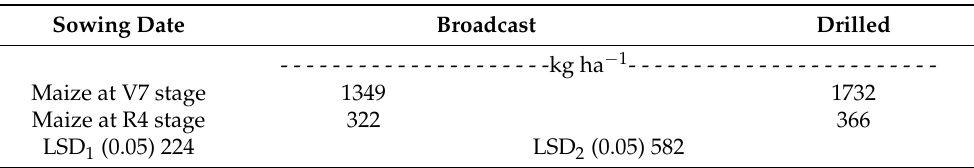
Table 5. Mean fall cover crop biomass yield for two sowing methods, sown at two different maize growth stages averaged across three cover crops, maize removal treatments, and four environments in 2018 and